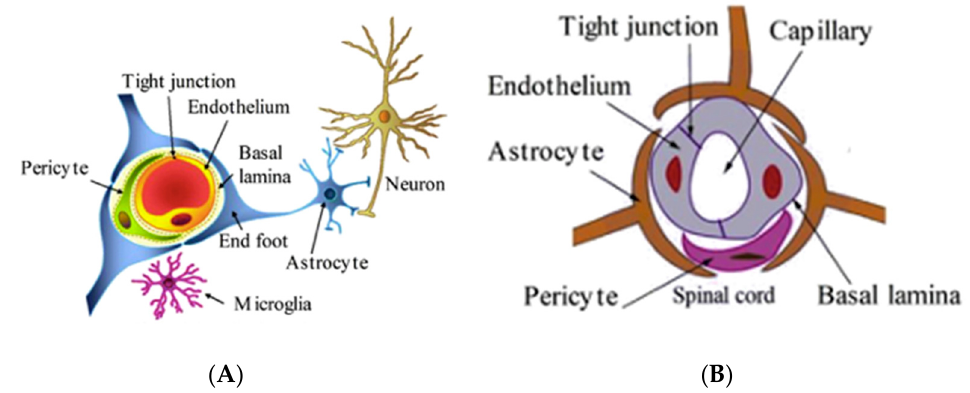
Figure 5. ( A ) Anatomy of BBB and ( B ) blood–spinal cord (BSCB) barrier.